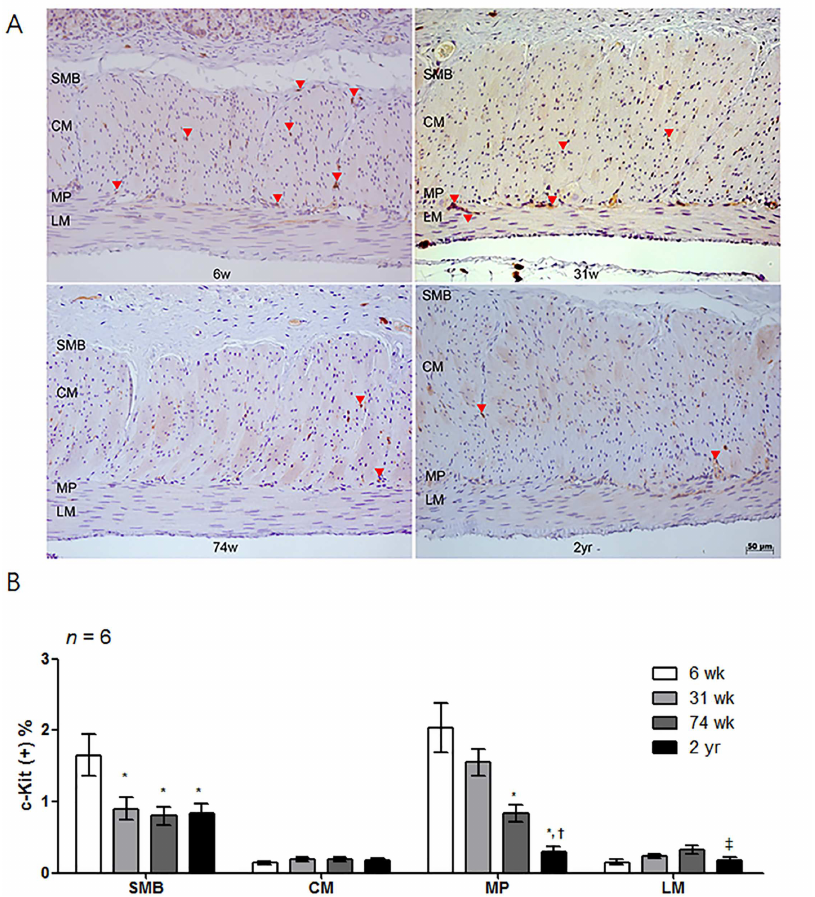
Fig 4. Analysis of c-Kit immunohistochemistry. (A) Photomicrographof c-Kit immunostaining of the proximalrat stomach. Arrows indicate the c-Kit immunoreactive cells (x200 magnification). (B) Comparison of the proportionof the c-Kit immunoreactive area of the SMB, MP, CM and LM in 6-, 31-, 74-wk- and 2-yr-old rats ( n = 6 per group). The proportionof the c-Kit immunoreactive area tendedto decrease with age. The result was expressedas the c-Kit positive percentage of the total area of each region. Each bar represents the mean ± SE. SMB, submucosal border; MP, myenteric plexus; CM, circular muscle; LM, longitudinal muscle. * P < 0.05 comparedwith 6-wk-old rats; † P < 0.05 comparedwith 31-wk-oldrats; ‡ P < 0.05 comparedwith 74-wk-oldrats.